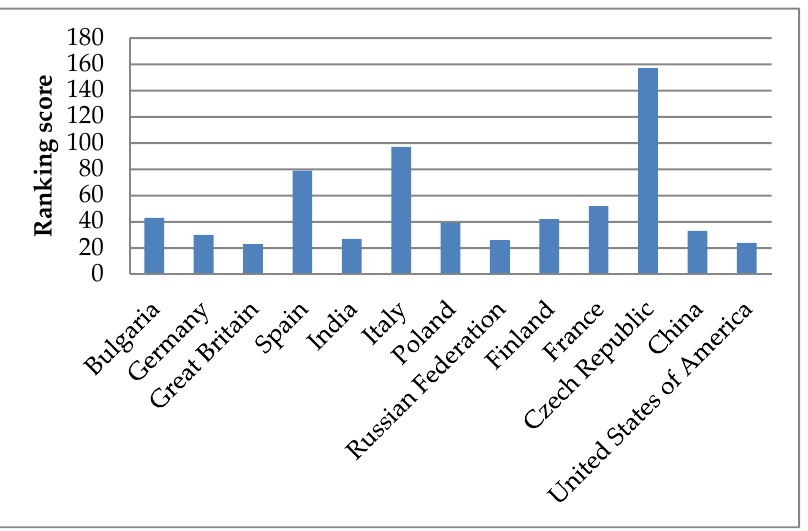
Figure 2. The ranking scores of a number of countries in the World Bank’s Doing Business ranking of construction permits for